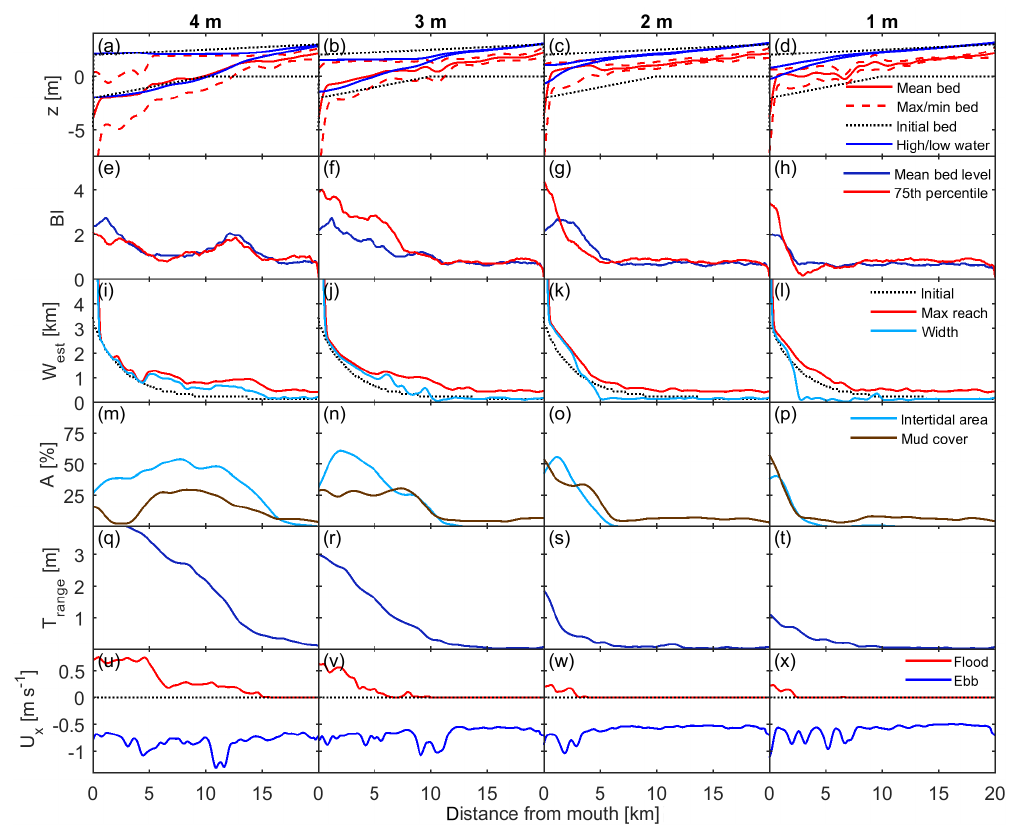
Figure A8. Hydrodynamics and morphology along estuaries with different tidal ranges after 2000 years. From left to right (columns): model with 4 (06), 3 (default, 01), 2 (05) and 1m (20) tidal range. (a–d) Minimum, mean and maximum bed elevation, high and low water level and minimum and maximum initial bed level, (e–h) braiding index and (i–l) estuary width defined as the initial width, maximum reach over the whole scenario run, the width of wet cells in the model, width defined by a threshold value that is used to mask the cells that are around the dry–wet cell threshold. (m–p) Intertidal area and mud cover as a percentage of the total area, (q–t) tidal range and (u–x) peak ebb and flood